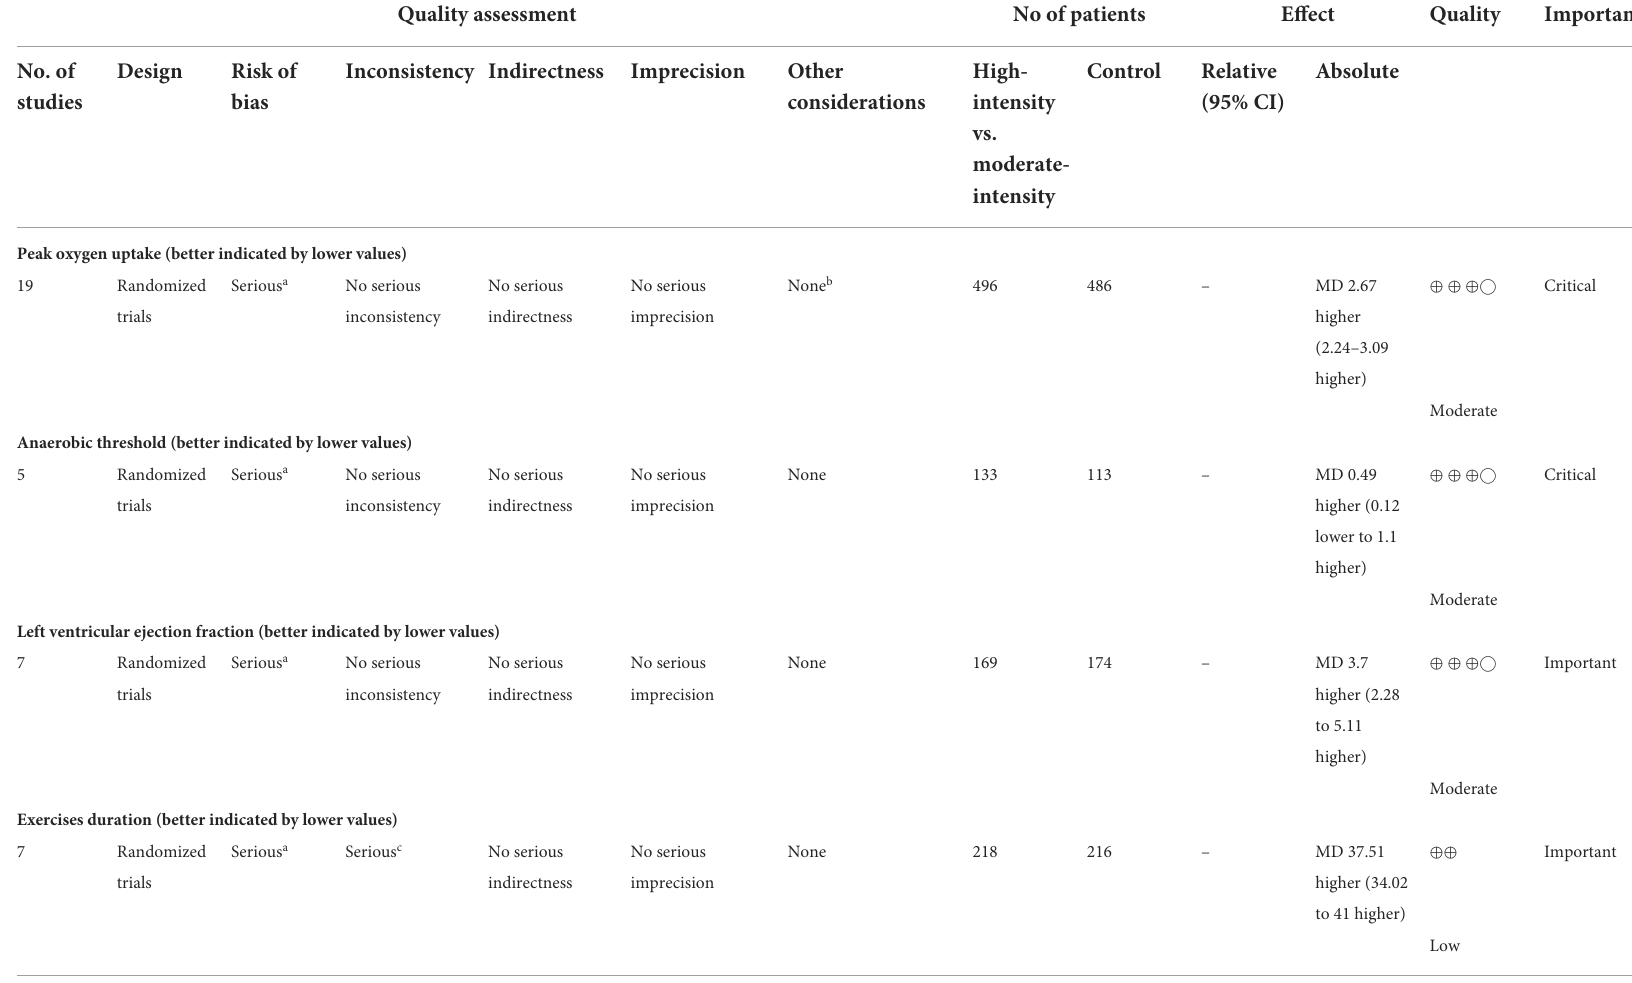
TABLE 3 Grading of Recommendations Assessment, Development, and Evaluation (GRADE)